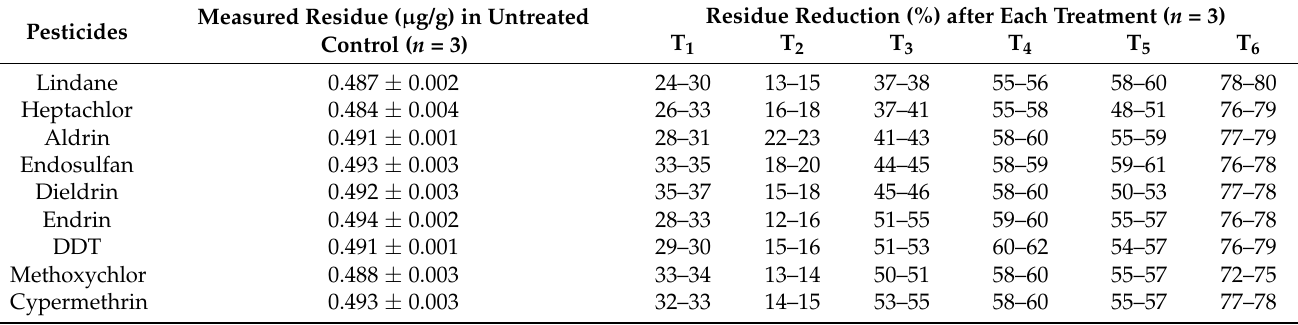
Table 4. Reduction in pesticide residues (%) in Channa striata by the six household treatment tech-